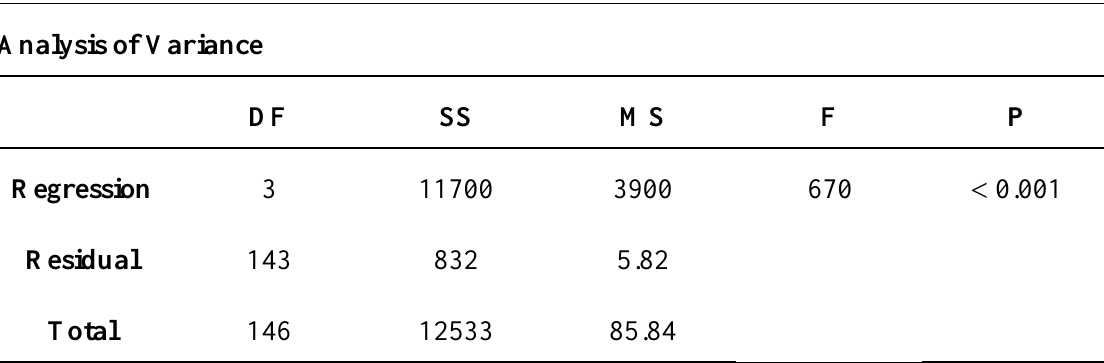
Table 2. Analysis of variance of the best QSPR